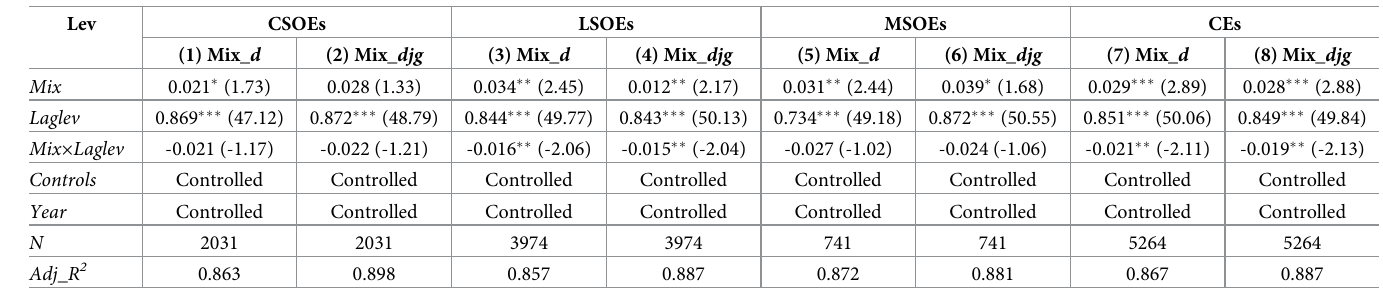
Table 7. The role of the level of government